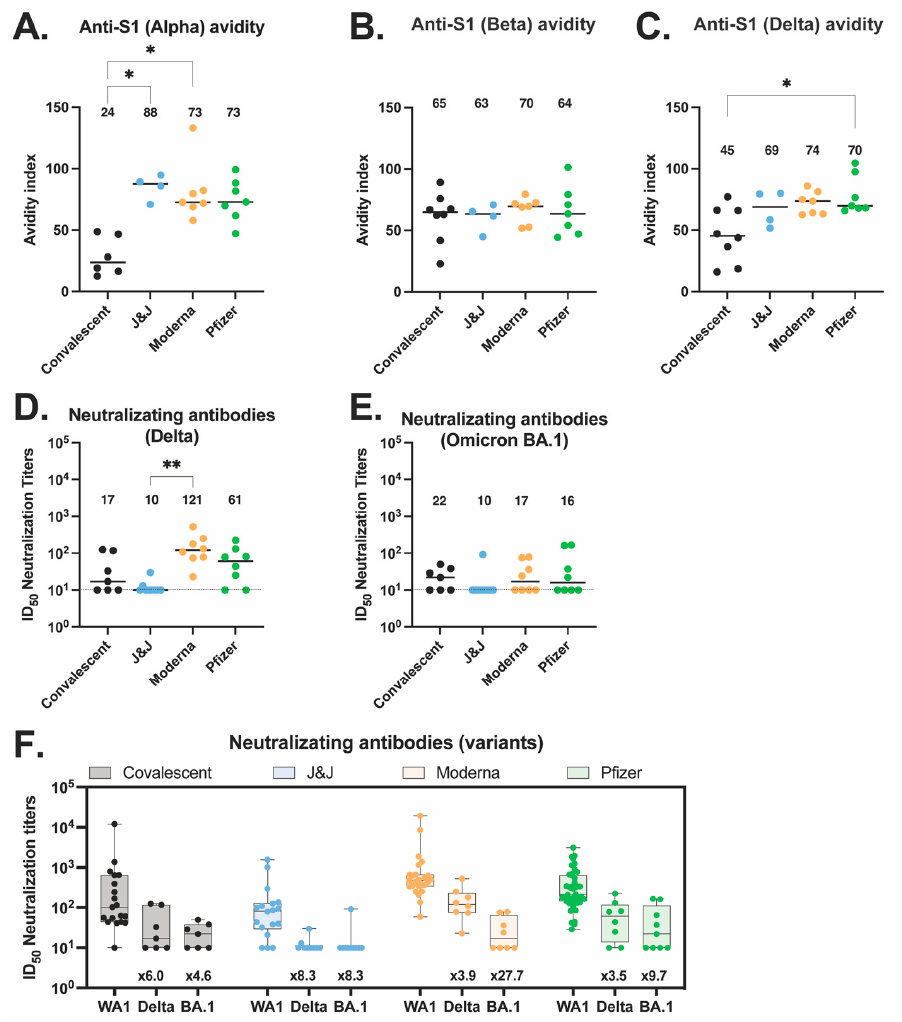
Figure 4. Antibody responses to variants of concerns elicited by vaccination or natural infection. ( A –